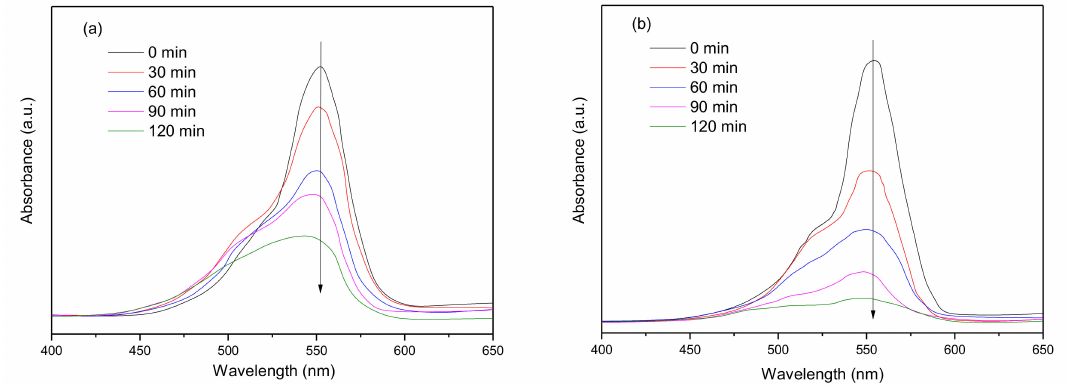
Figure 8. ( a ) TiO 2 / hectorite and ( b ) g-C 3 N 4 / TiO 2 / hectorite under visible light irradiation.